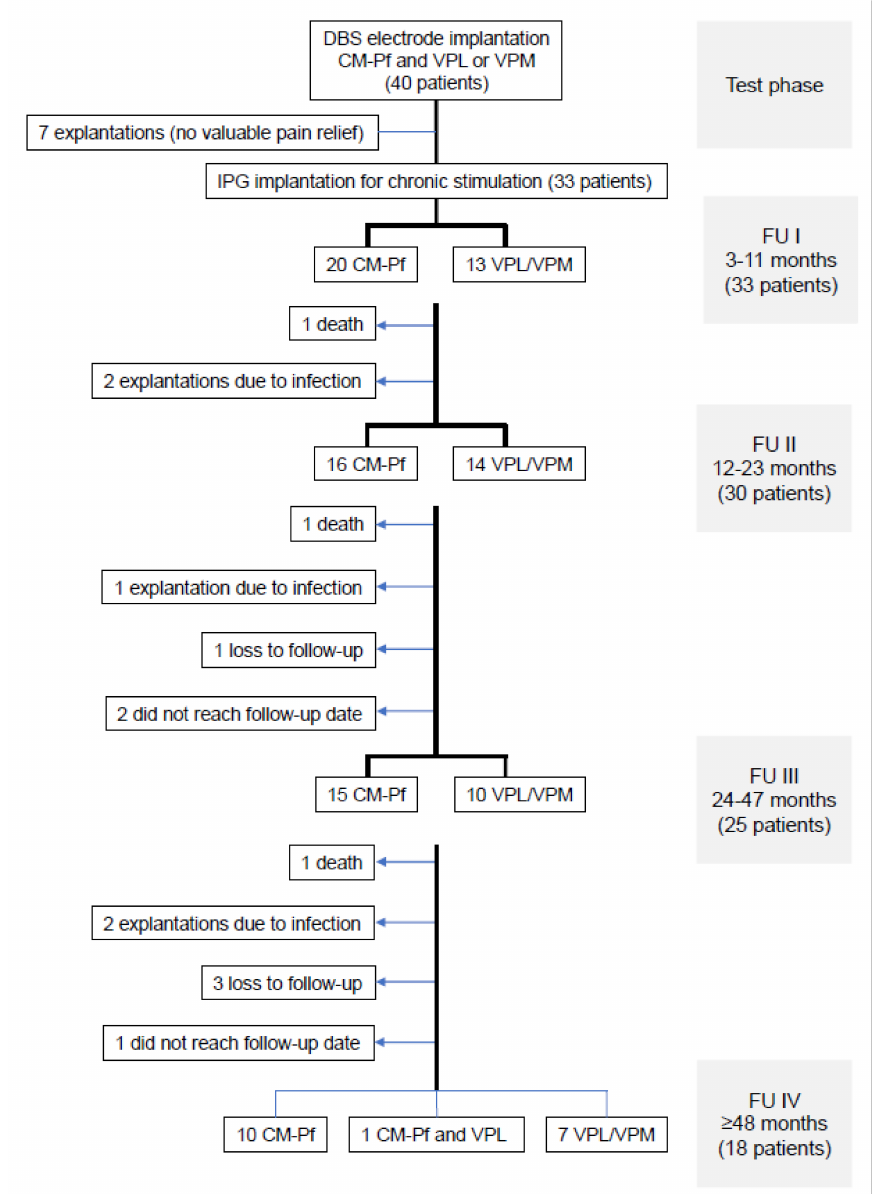
Figure 1. Flowchart illustrating the numbers of patients available at the different follow-up periods. The reasons for patient attrition are shown on the left side of the flow chart. CM–Pf = centromedian– parafascicular nucleus, VPL = ventroposterolateral nucleus (thalami); VPM = ventroposteromedial nucleus